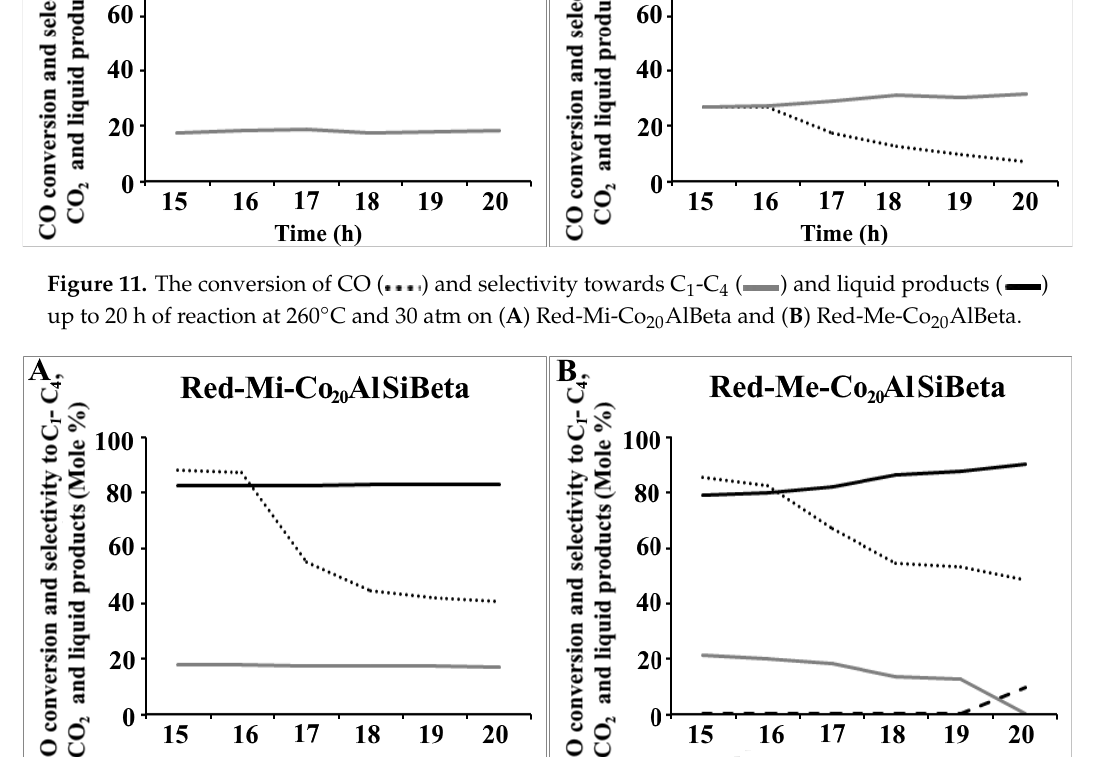
Figure 12. The conversion of CO ( ) and selectivity towards C 1 -C 4 ( ), CO 2 ( ) and liquid products ( ) up to 20 h of reaction at 260 ℃ and 30 atm on ( A ) Red-Mi-Co 20 AlSiBeta and ( B ) Red-Me-Co 20 AlSiBeta.